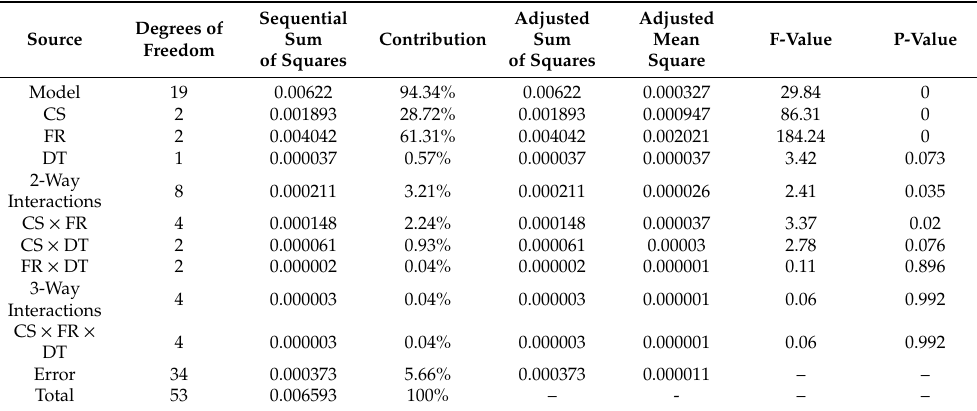
Table 8. ANOVA for hole